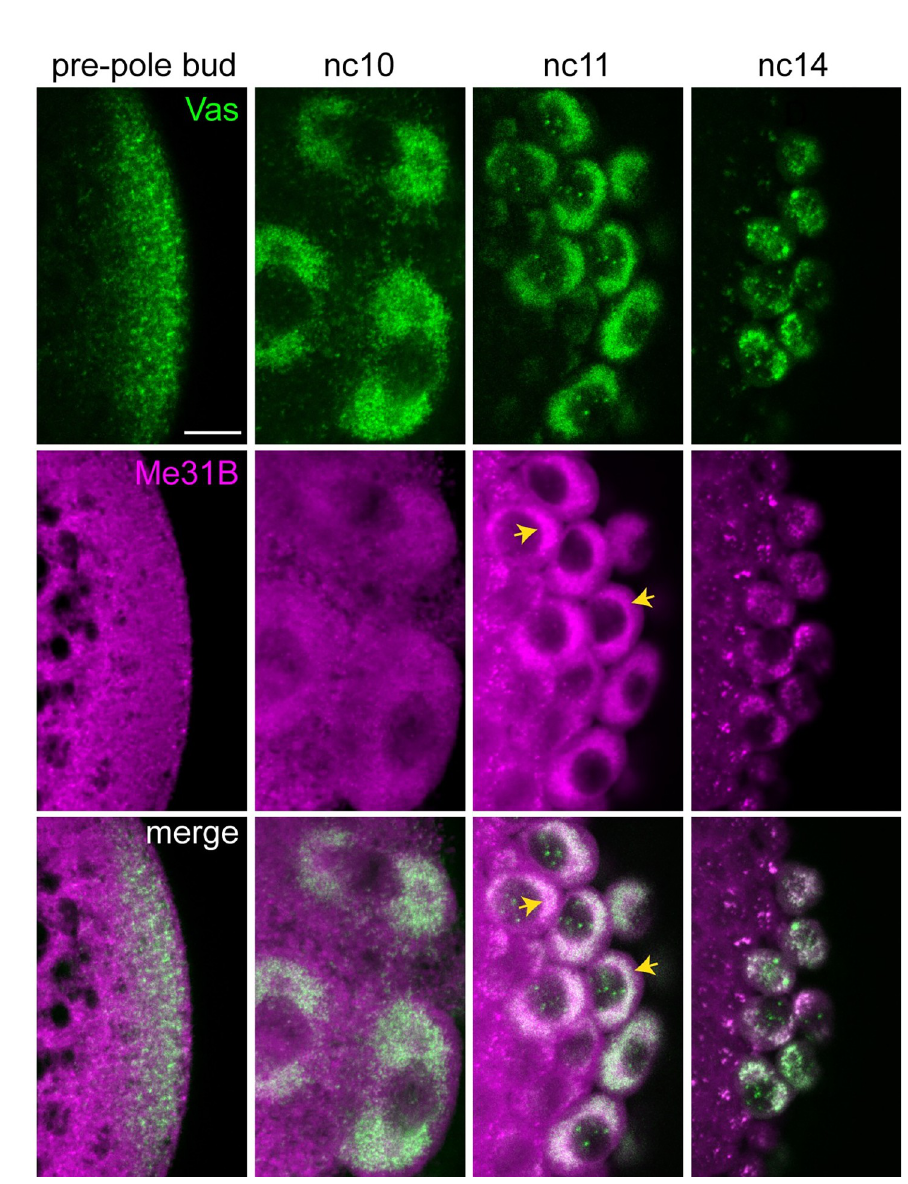
Fig 7. Enrichment of Me31B in germ granules appears prior to Patr-1 enrichment. Single confocal sections of the posterior region of syncytial blastoderm stage embryos expressing Me31B-gfp and vas-ko transgenes. Vas-KO and Me31B-GFP were detected by direct fluorescence. Yellow arrows indicate the Me31B-GFP signal. Scale bar: 10 μ m.